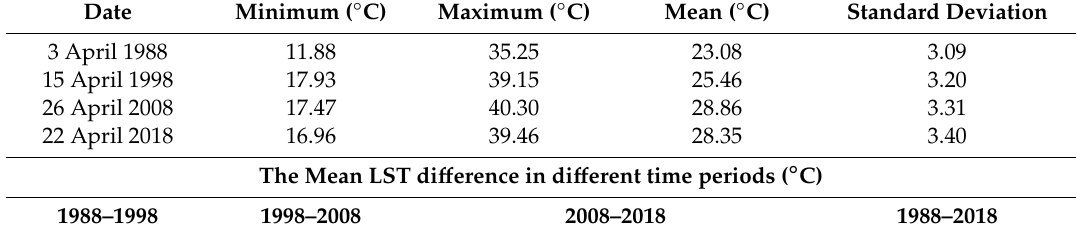
Table 2. Maximum, minimum, and mean LST ( ◦ C) values in Kathmandu